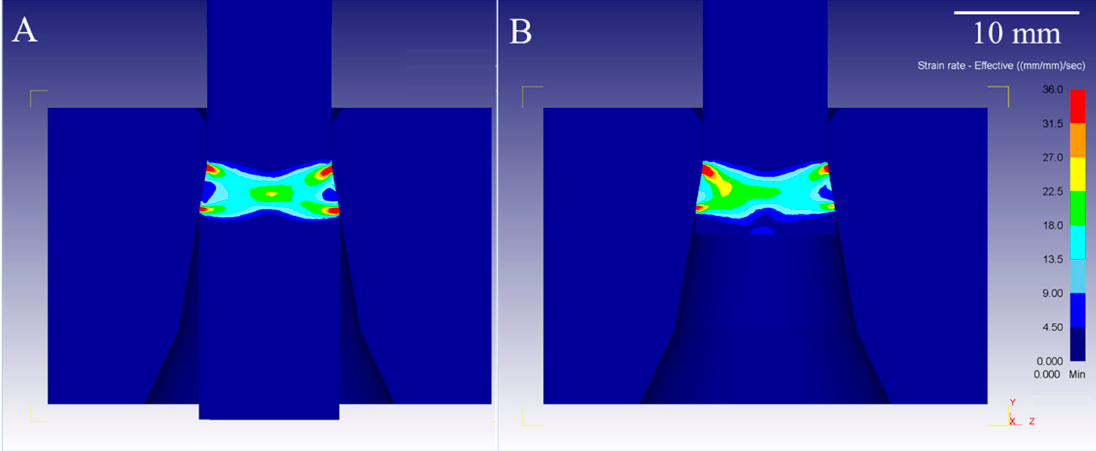
Figure 4 . FEM analysis of the strain rate during wire drawing process of copper: ( A ) — stationary conditions; ( B ) — non- stationary conditions .